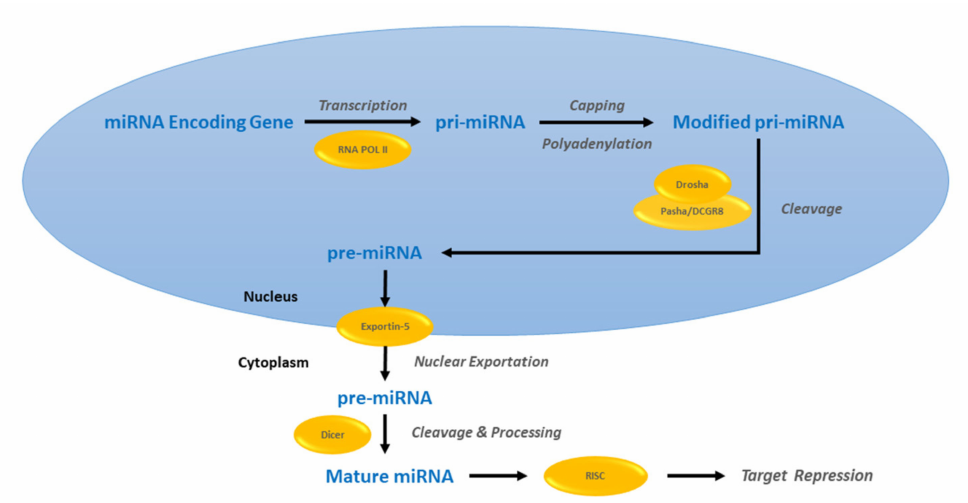
Figure 1. MicroRNA (miRNA) biogenesis and target gene repression. A miRNA encoding gene is transcribed into a primary miRNA (pri-miRNA), which undergoes subsequent post-transcriptional modification and then cleavage to generate a precursor miRNA (pre-miRNA). These pre-miRNA molecules are exported out of the nucleus and further cleaved and processed to their final form, mature